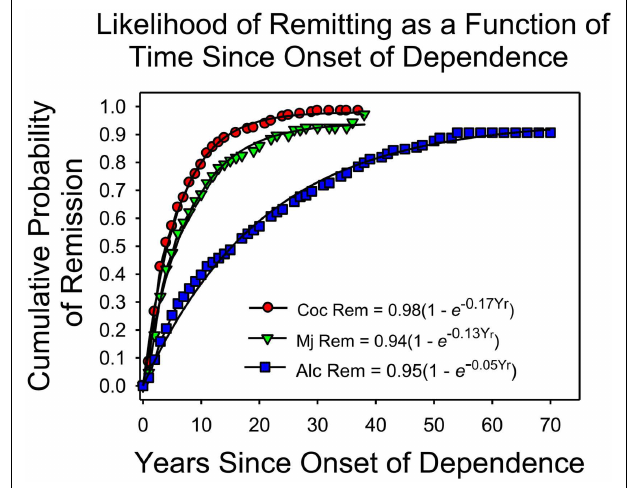
FIGURE 1 |The cumulative frequency of remission as a function of time since the onset of dependence, based on Lopez-Quintero et al.’s (2011) report .The proportion of addicts who quit each year was approximately constant.The smooth curves are based on the negative exponential equations listed in the